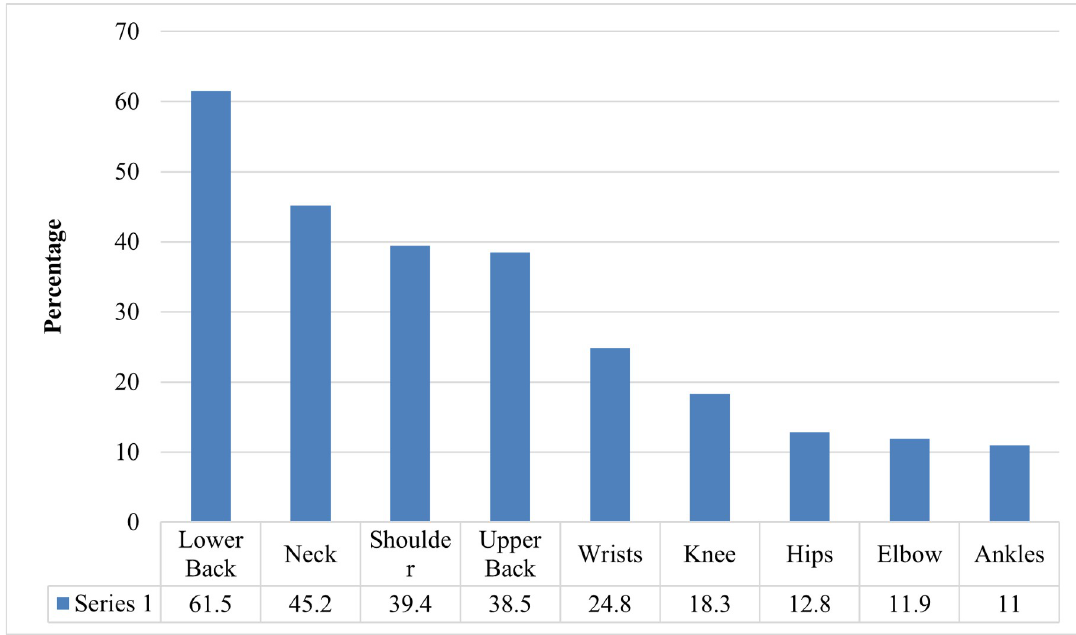
Fig 1. Site of musculoskeletal discomfort in study